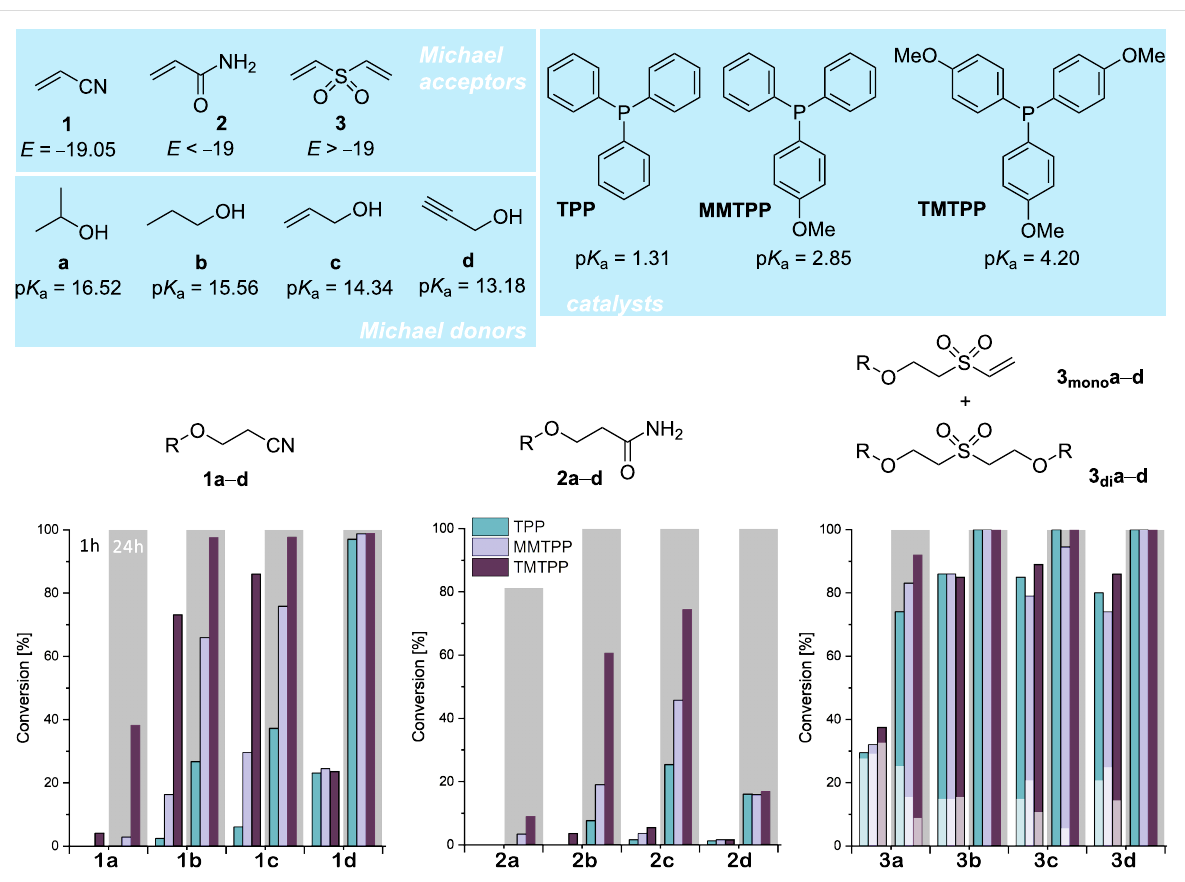
Figure 1: Above: Michael acceptors, Michael donors and catalysts used in this study; p K a (respectively p K a of the conjugated acid in case of phos- phines) calculated using the p K a prediction platform (neural network result for solvent H 2 O) available at pka.luo-group.com [20]; below: Conversion of the oxa-Michael reaction of acrylonitrile (left), acrylamide (middle), and divinyl sulfone (right; double bond conversion is given; light sections of the bar represent the share of 3 mono a – d , dark sections represent the share of 3 di a – d ) with the alcohols propan-2-ol ( a ), propan-1-ol ( b ), prop-2-en-1-ol ( c ), and prop-2-yn-1-ol ( d ) catalyzed by triphenylphosphine (TPP), (4-methoxyphenyl)diphenylphosphine (MMTPP), and tris(4-methoxyphenyl)phosphine (TMTPP). Reaction conditions: 1 equiv Michael acceptor, 2 equiv alcohol (in case of 3 , 3 equiv alcohol), 1 mol % catalyst (with respect to the Michael acceptor), 1 h and 24 h (bars above grey boxes) at room temperature (23 °C); no solvent used.